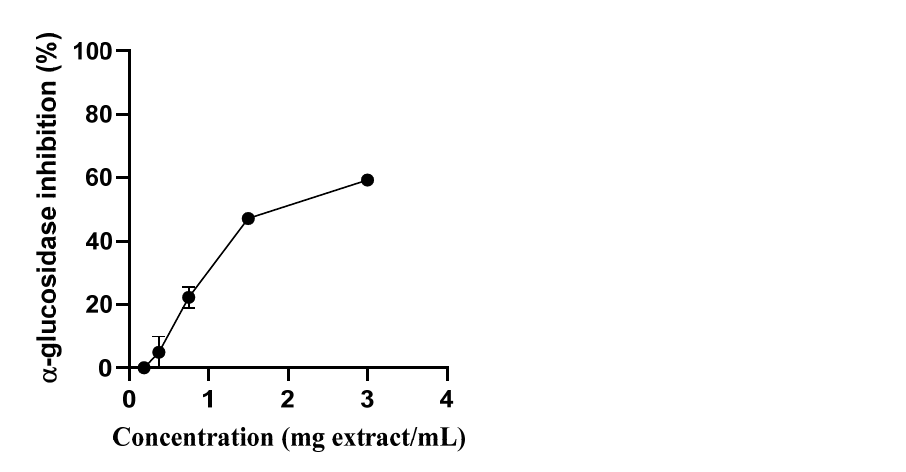
Figure 2. Inhibition of the activity of α -glucosidase by S. betaceum aqueous extract. Results are expressed as mean ± SD of three independent experiments, each performed in triplicate. expressed as mean ± SD of three independent experiments, each performed in